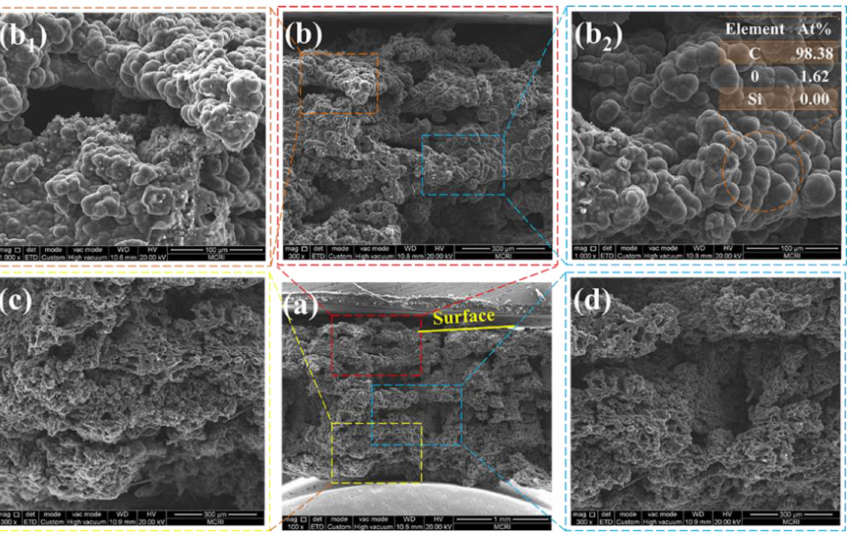
Figure 14. The SEM micrographs of the cross-section of the char layer of (AM/HM) 10 ( a ). (upper ( b , b 1 , b 2 ), middle ( d ) and bottom ( c ) of char